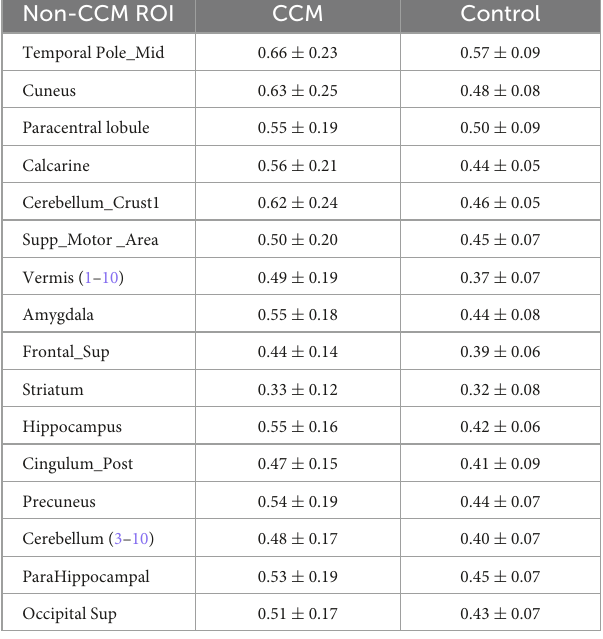
TABLE 1 Regional flutriciclamide SUVs (g/ml) in the global brain tissue region for both the CCM and control group.